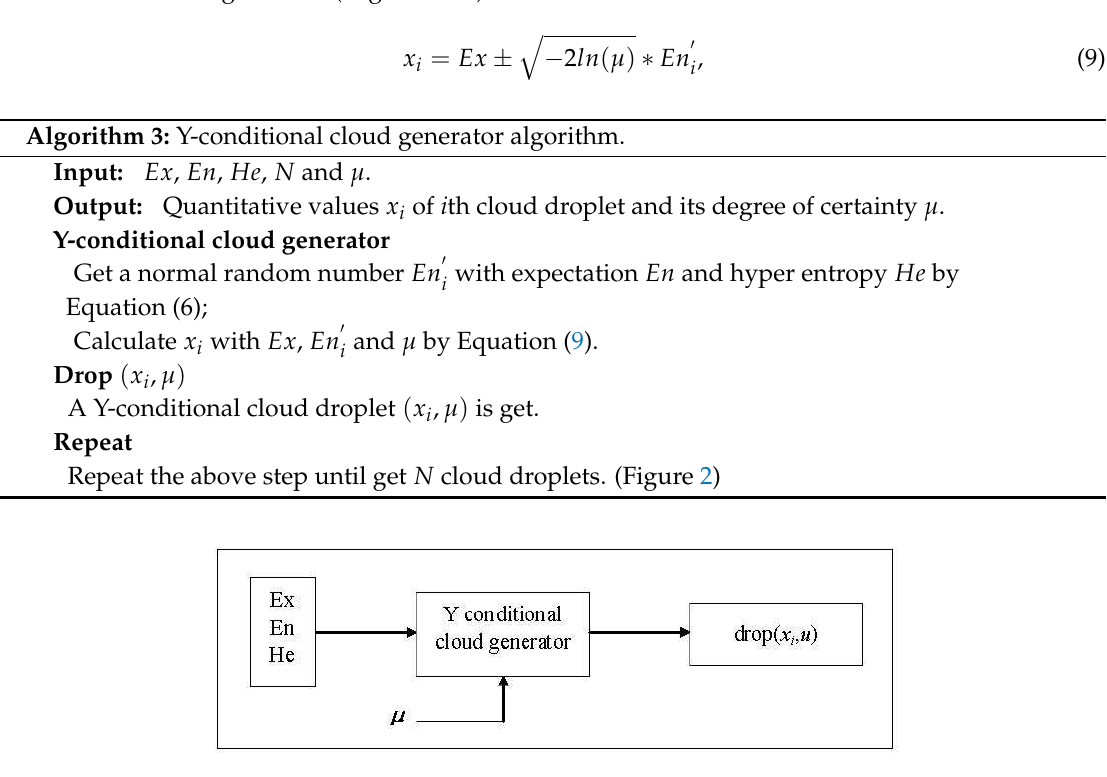
Figure 2. Y-Conditional cloud